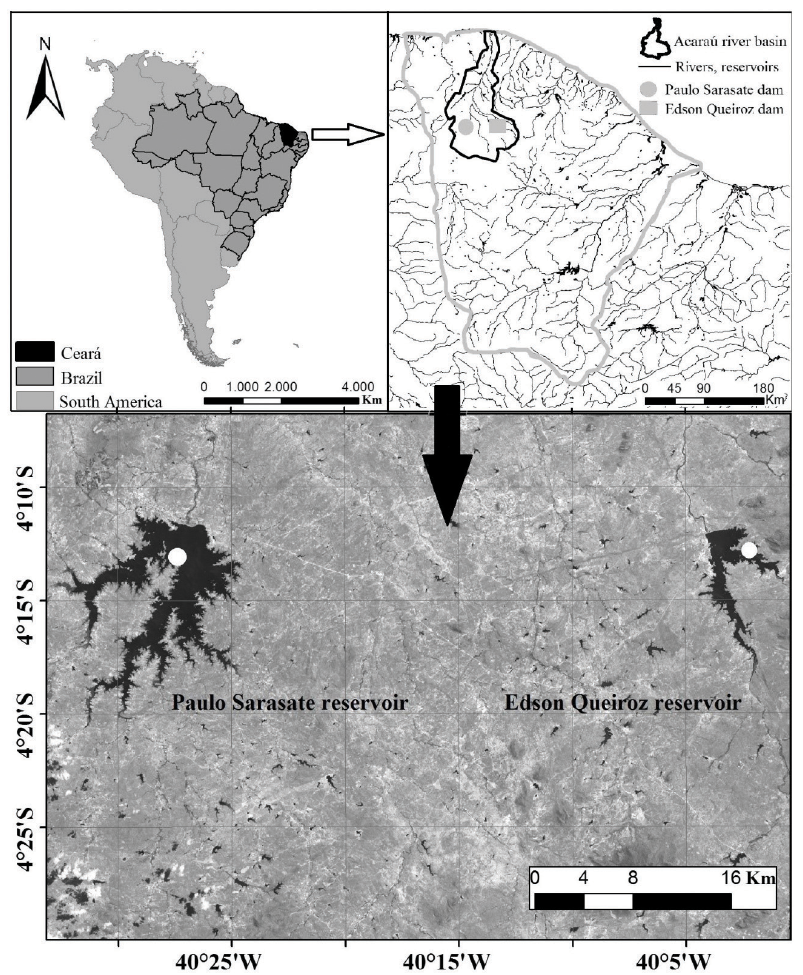
Figure 1. Location of the Paulo Sarasate (PS) and the Edson Queiroz (EQ) reservoirs in the semiarid middle Acaraú river basin (Ceará, Northeastern Brazil) with the respective fish sampling sites (white dots).